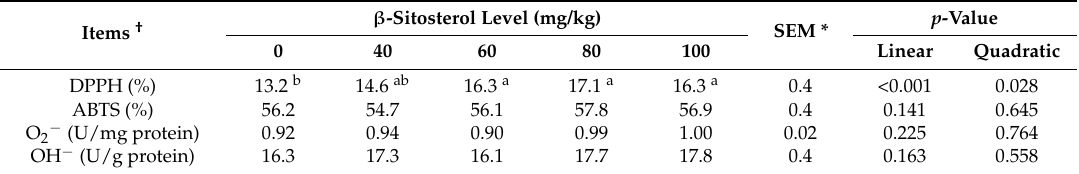
Table 5. Effect of dietary β -sitosterol supplementation at different levels on free radical scavenging activity of breast muscle in